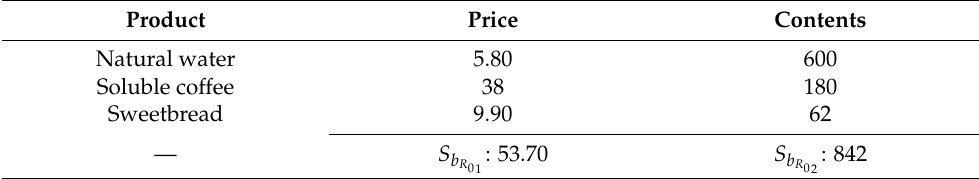
Table 19. DM’s initial shopping list for the